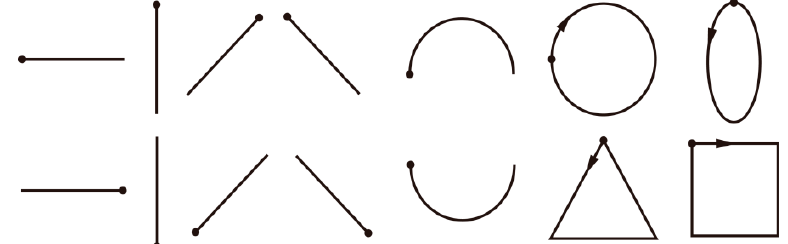
Figure 1. The fourteen basic one-stroke hand-drawn shapes used in our study. Dots represent starting points, arrows represent directions. The shapes are, from left to right, in order, horizontal line, vertical line, forward slash, backslash, arch, circle, ellipse, reversed horizontal line, reversed vertical line, reversed forward slash, reversed backslash, reversed arch, square and triangle.